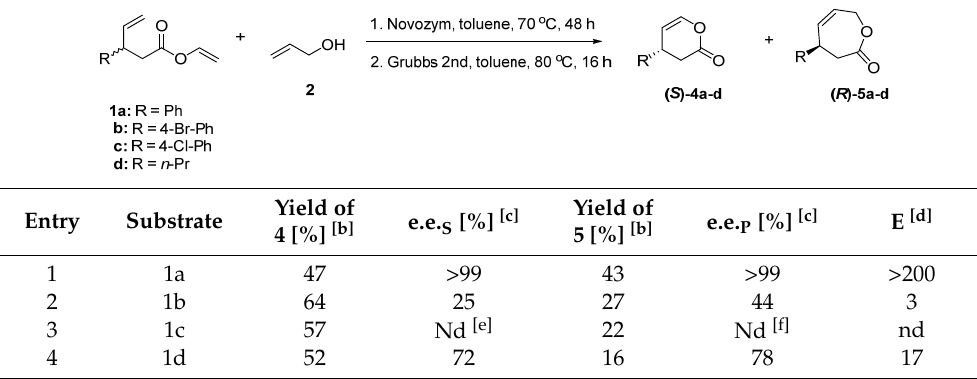
Table 3. One-pot two-step synthesis of lactones 4 and 5 [a] . Table 3. One ‐ pot two ‐ step synthesis of lactones 4 and 5 [a] .